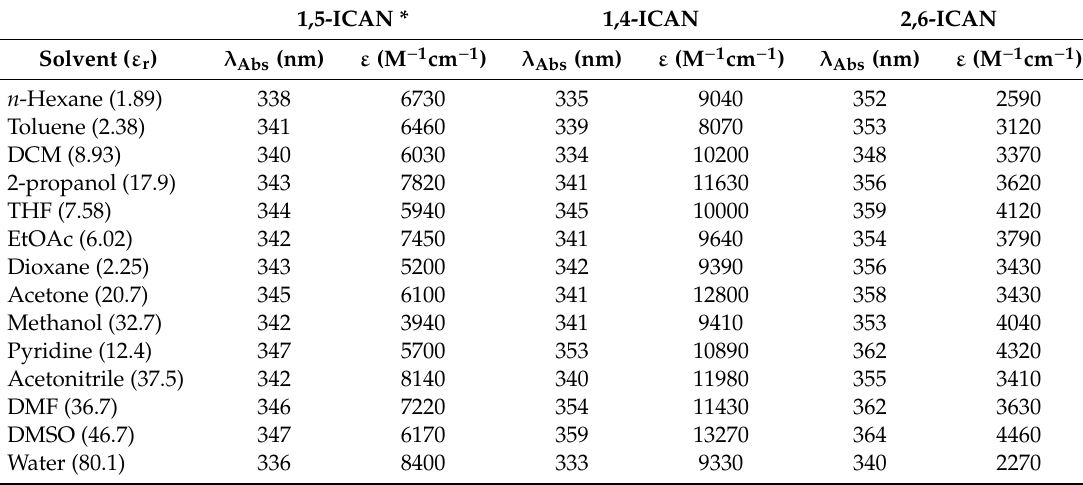
Table 1. The maximum absorption wavelengths ( λ Abs ) and the molar absorption coefficients at λ Abs ( ε ) determined in various solvents for the 1,5-ICAN, 1,4-ICAN, and 2,6-ICAN isomers. The dielectric constants of the solvents ( ε r ) are listed next to the solvent names.